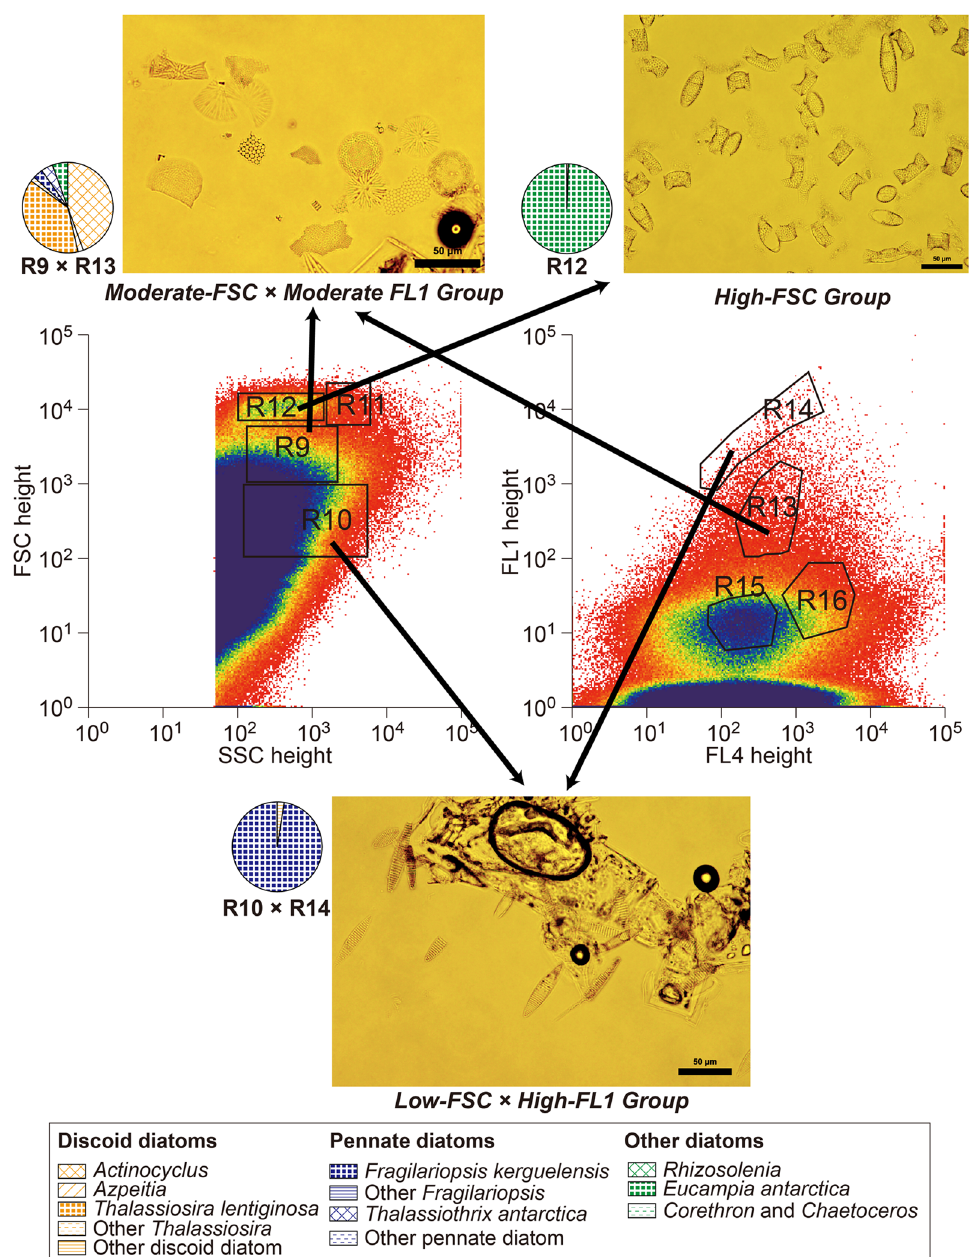
Fig. 6 Flow cytograms of sample 382-U1538A-3-1, 24–25 cm (last glacial) and pie charts/photomicrographs showing the diatom assemblages obtained by sorting of the following composite regions: Regions 9 and 13 (discoid-diatom-rich); Regions 10 and 14 ( Fragilariopsis -rich); and Region 12 ( Eucampia -rich). Sorting of composite region R12 and R15 also achieved purification of Eucampia antarctica (Additional file 2: Table S4). The crystalline materials in the micrographs are NaCl crystals in the sheath